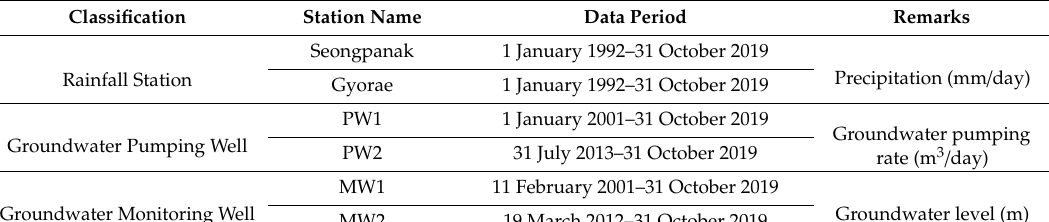
Figure 2. Comparison of daily precipitation in Seongpanak and Gyorae rainfall stations.